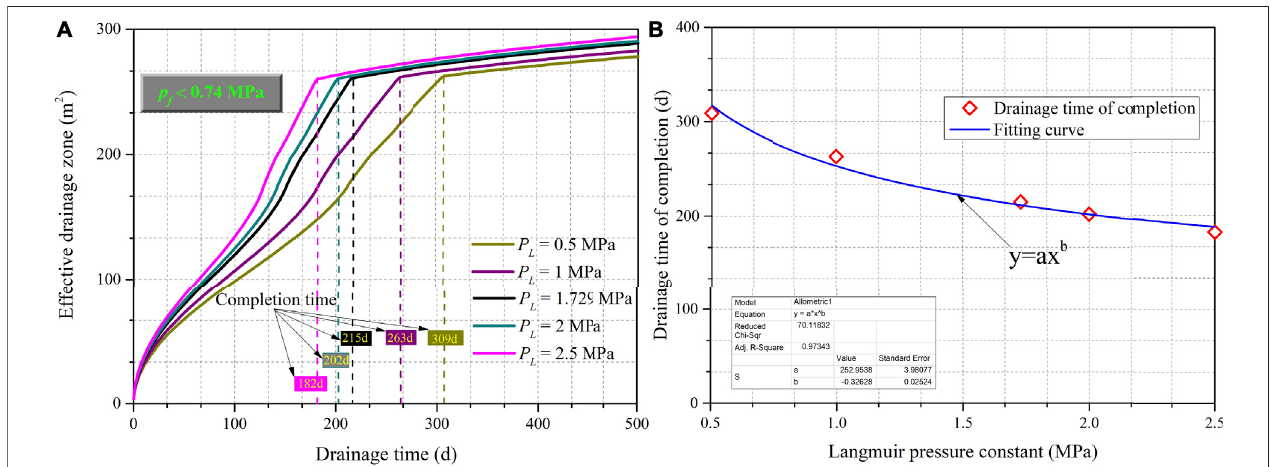
FIGURE 12| Effect of changes in the Langmuir pressure constant ( P L ) on drainage performance. (A) Effective drainage zone areas vs drainage time in days for fi ve different P L ’ s (B) Drainage completion time vs. Langmuir pressure constants.